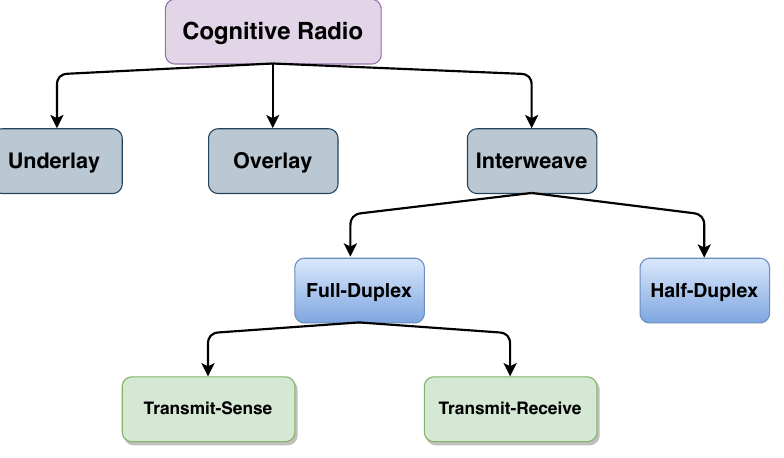
Figure 1. Cognitive Radio (CR) access